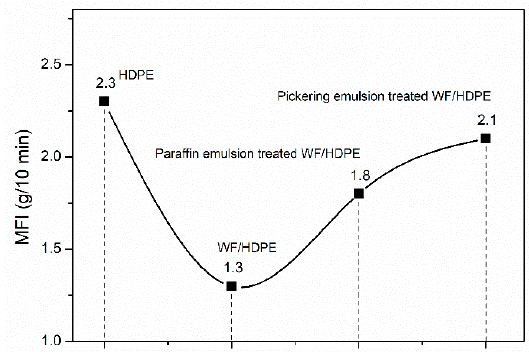
Figure 6. Melt flow index of high-density polyethene (HDPE) and WF/HDPE mixture.